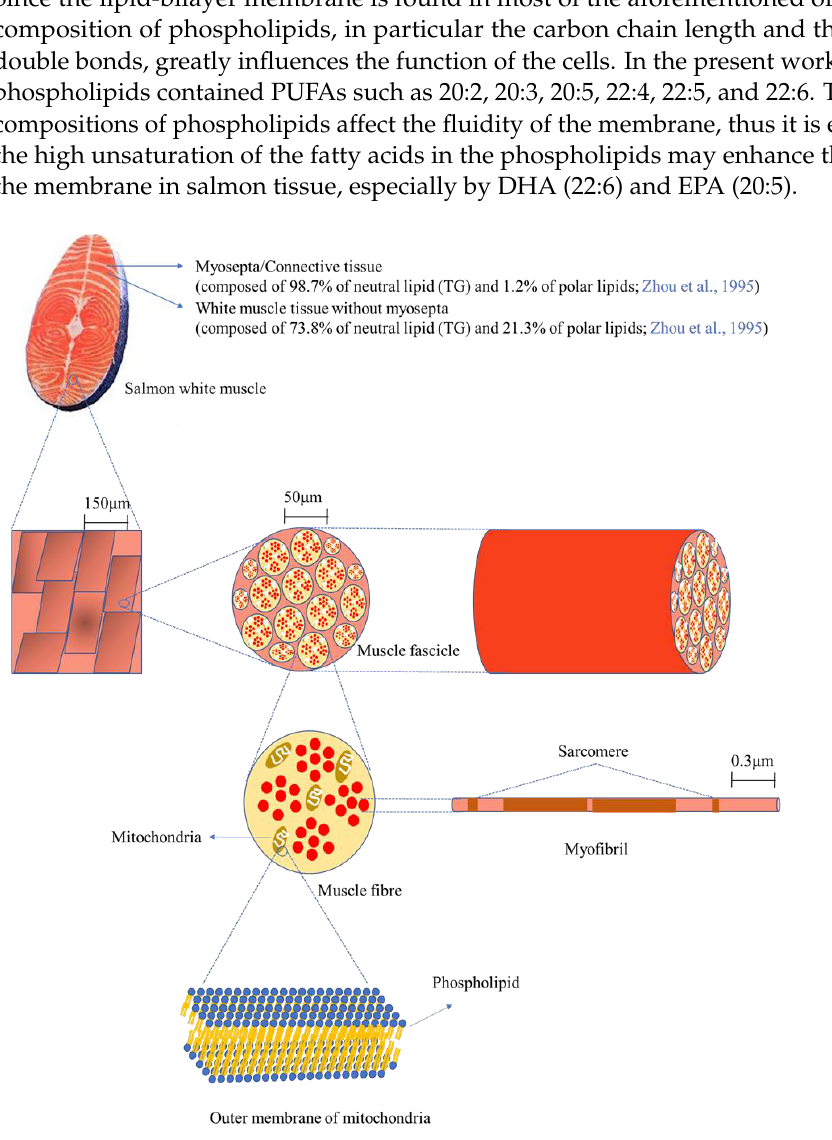
Figure 4. The microstructure of the white muscle tissue of salmon and the localization of phospholipids in the outer membrane of mitochondria (other organelles such as the nucleus are not shown).